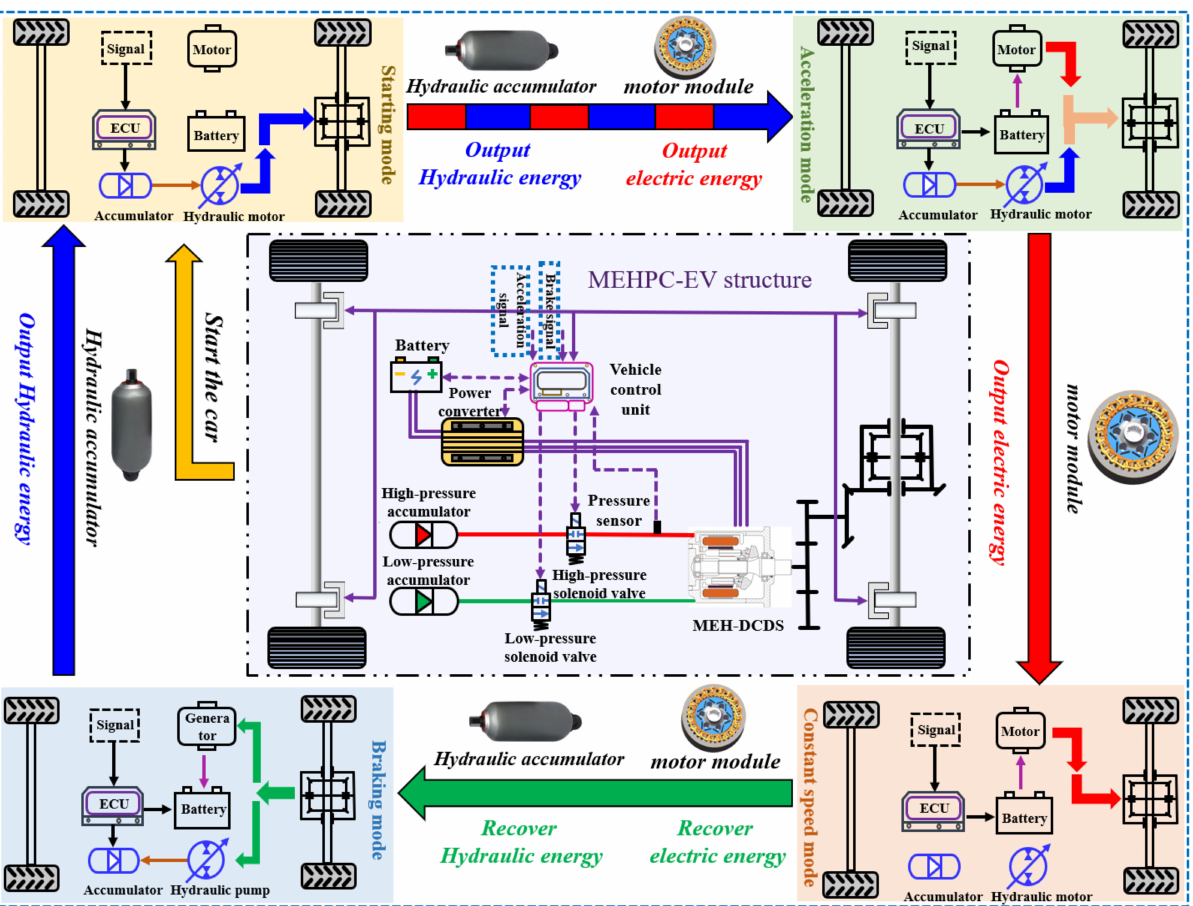
Figure 9. Diagram of Mechanical-Electric-Hydraulic Power Coupling Electric Vehicle (MEHPC-EV) structure and energy